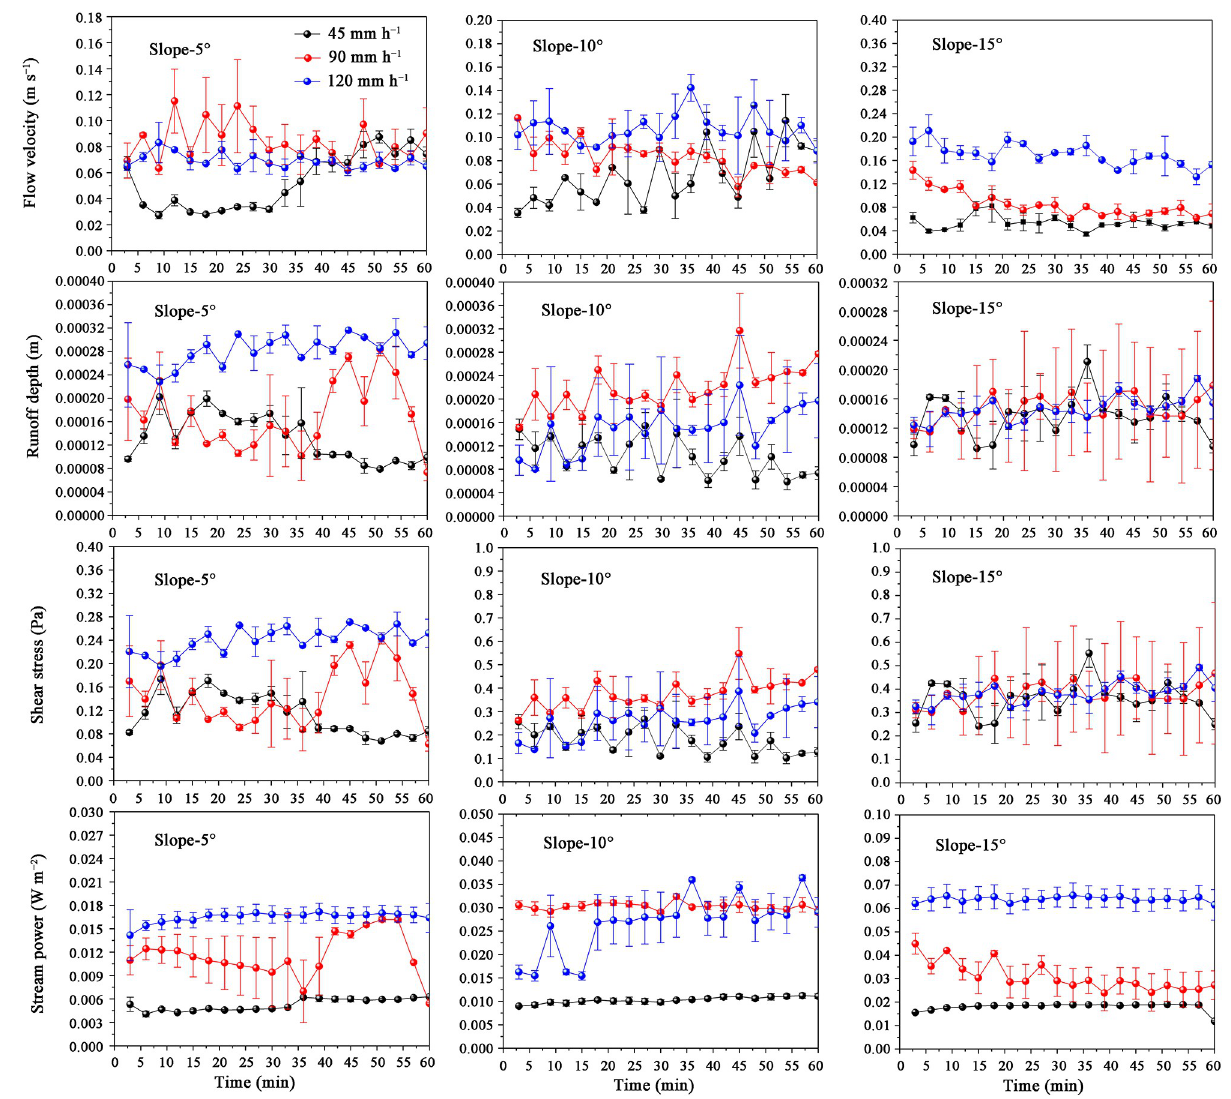
Fig 2. Changing trend of flow velocity, runoff depth, shear stress, and stream power during the erosion process. https://doi.org/10.1371/journal.pone.0262865.g002 Table 2. Runoff hydraulic characteristics (runoff rate, flow velocity, runoff depth, shear stress and stream power) under different rainfall intensity and slope. Treatment (rainfall